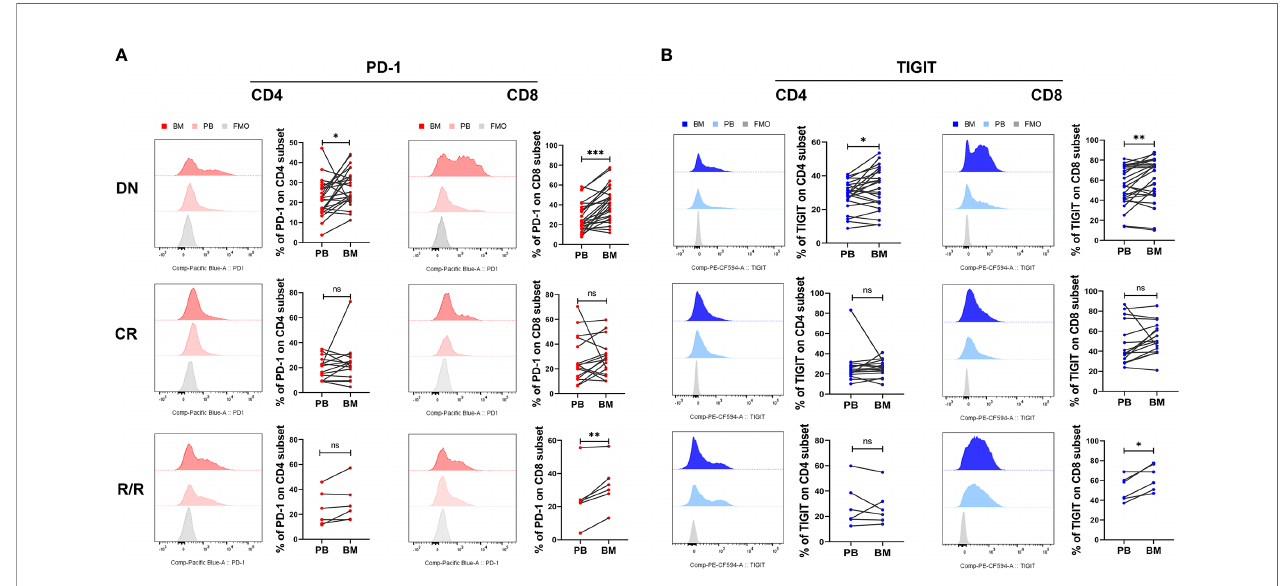
FIGURE 3 | BM CD4 + and CD8 + T cells from DN-AML and R/R-AML patients have a higher percentage of PD-1- and TIGIT-expressing T cells than matched PB. (A) The fl ow-cytometry analysis detected an increase in the frequency of PD-1-expressing CD4 + and CD8 + T cells in the BM of DN-AML patients compared with matched PB (CD4, n=24; CD8, n=27); the expression of PD-1 on CD4 + and CD8 + T cells between PB and BM was not different in the CR-AML cohort (CD4, n=15; CD8, n=16). Increased PD-1 expression was also detected in BM CD8 + T cells from R/R patients (n=6). (B) Flow-cytometry analysis detected an increased frequency of TIGIT-expressing CD4 + and CD8 + T cells in the BM of DN-AML patients compared with matched PB (CD4, n=24; CD8, n=27); the expression of TIGIT on CD4 + and CD8 + T cells between PB and BM was not different in the CR-AML cohort (CD4, n=15; CD8, n=16); increased TIGIT expression was also detected in the BM CD8 + T cells of R/R patients (n=6). The p values in (A, B) were calculated by the paired student ’ s t-test. * p < 0.05, ** p < 0.01, *** p < 0.001, ns denotes not signi fi